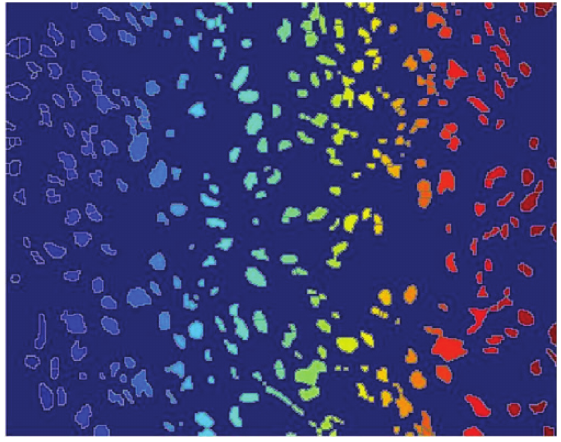
Figure 7: Sample-labeled